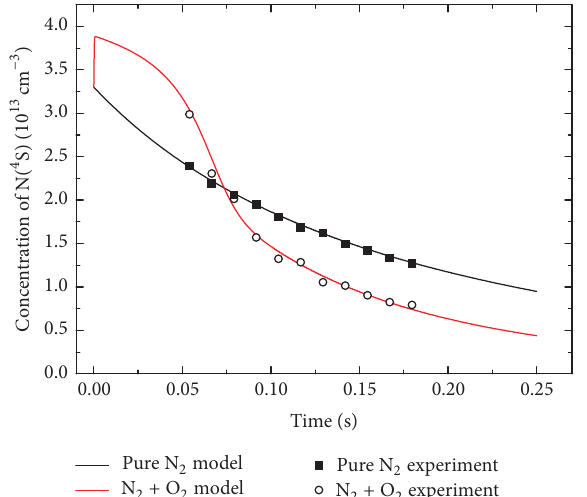
Figure 9: The parameters from the fit are used to calculate the extrapolation to shorter afterglow times of kinetic models of atmospheric pressure nitrogen afterglow with and without oxygen